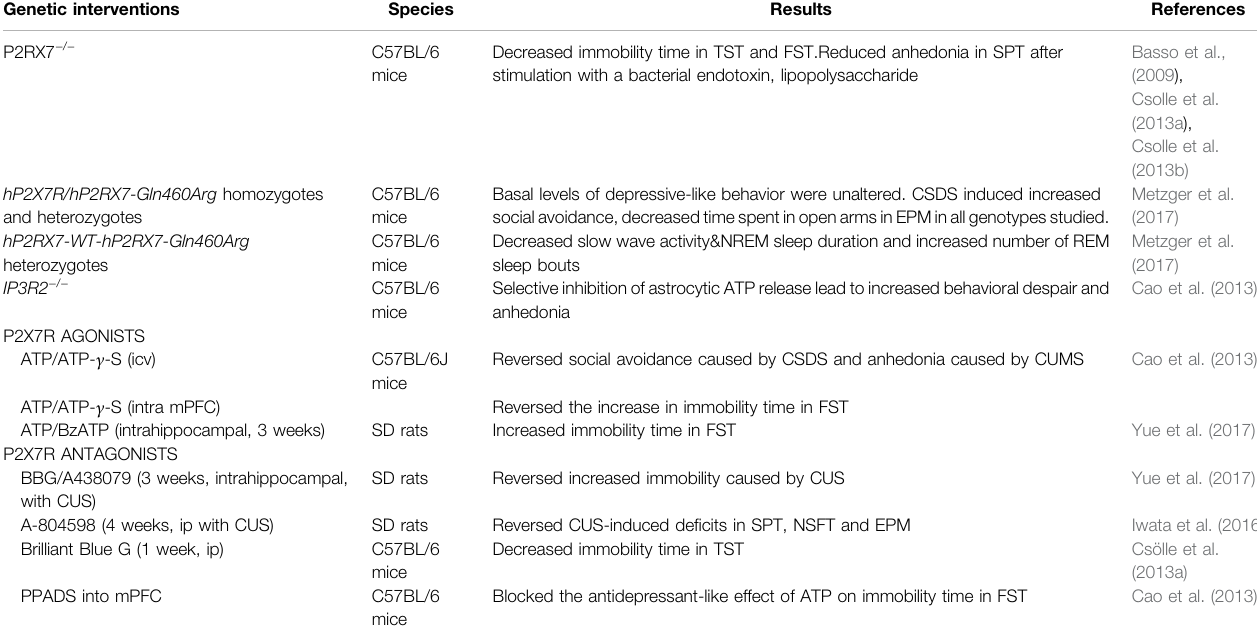
TABLE 1 | Behavioral effects of interventions to P2X7R expression and functions. Genetic interventions Species